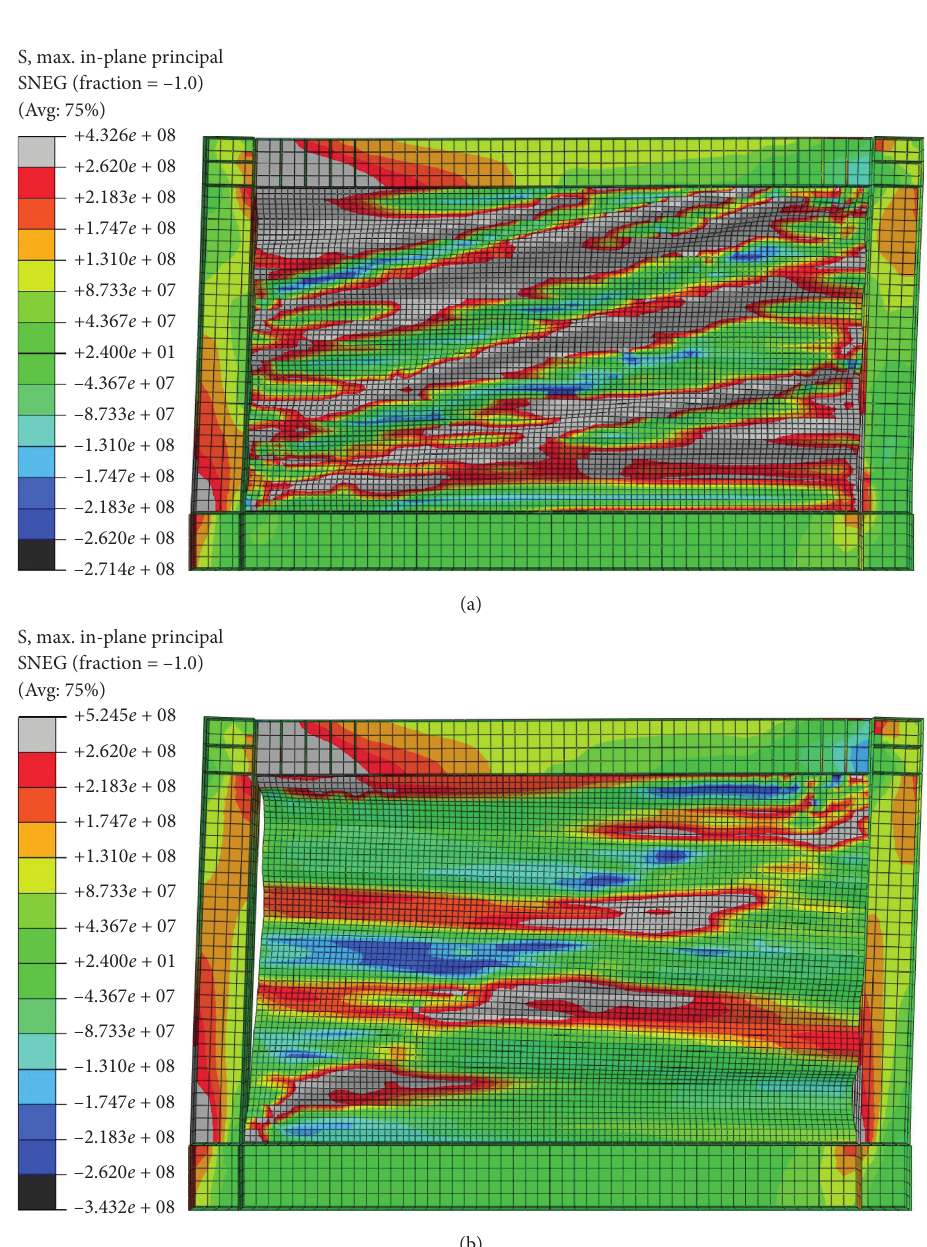
Figure 11: Maximum in-plane principal stress contours in H-CSPSW. (a) Fully connected H-CSPSW. (b) Beam-only-connected